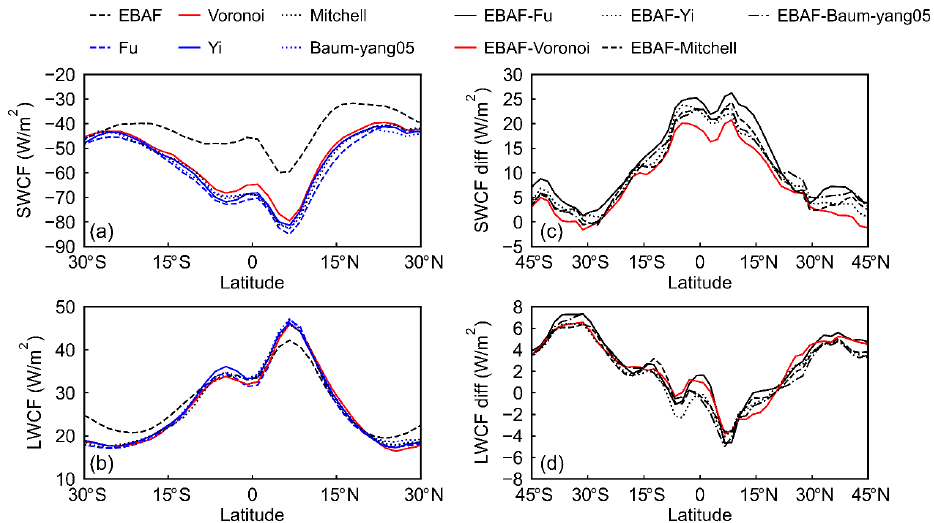
Figure 9. Comparison of 10-year zonally averaged annual mean (a) SWCF and (b) LWCF between the Voronoi, Mitchell, Fu, Baum-yang05 and Yi schemes and CERES EBAF. EBAF minus the five schemes’ differences in (c) SWCF and (d) LWCF.